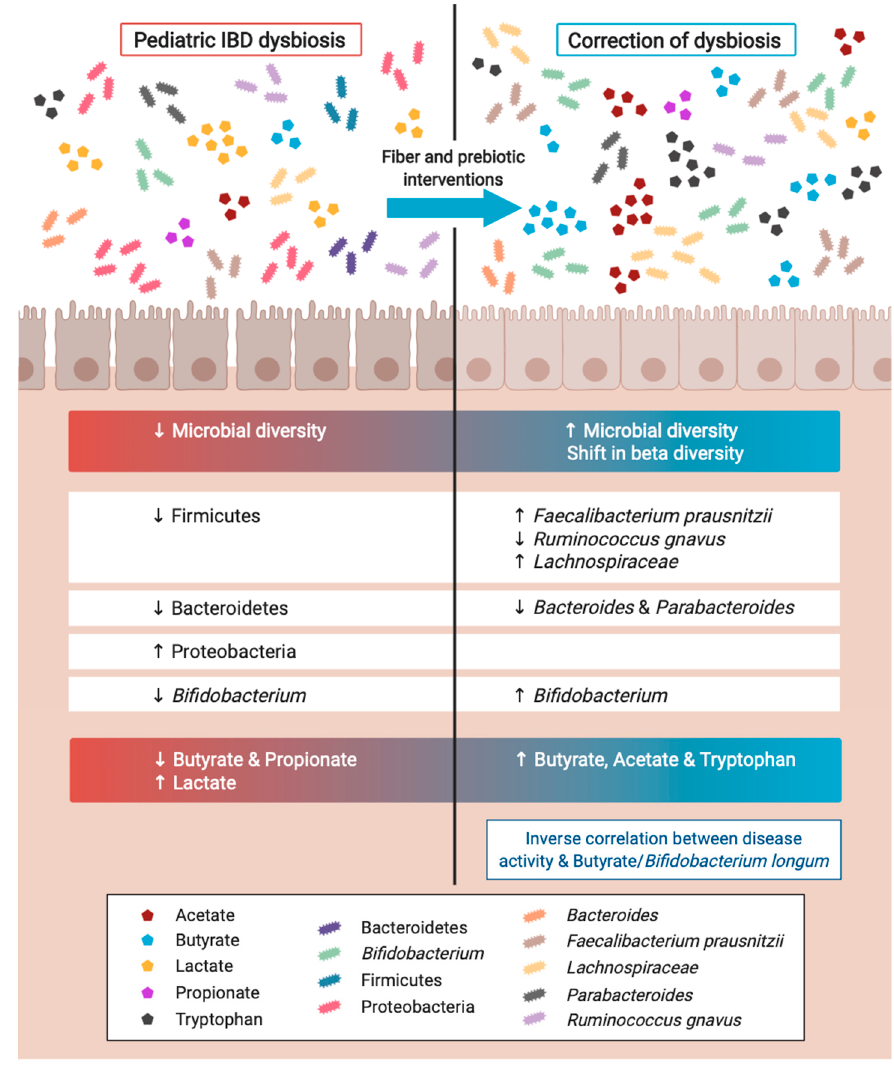
Figure 1. Pediatric IBD patients appear to have a dysbiotic gut microbiome profile compared to healthy controls. Based on the results generated from adult IBD studies, there is potential for fiber and prebiotic interventions to correct the dysbiosis observed in pediatric IBD patients. Created with BioRender.com. IBD: inflammatory bowel disease.